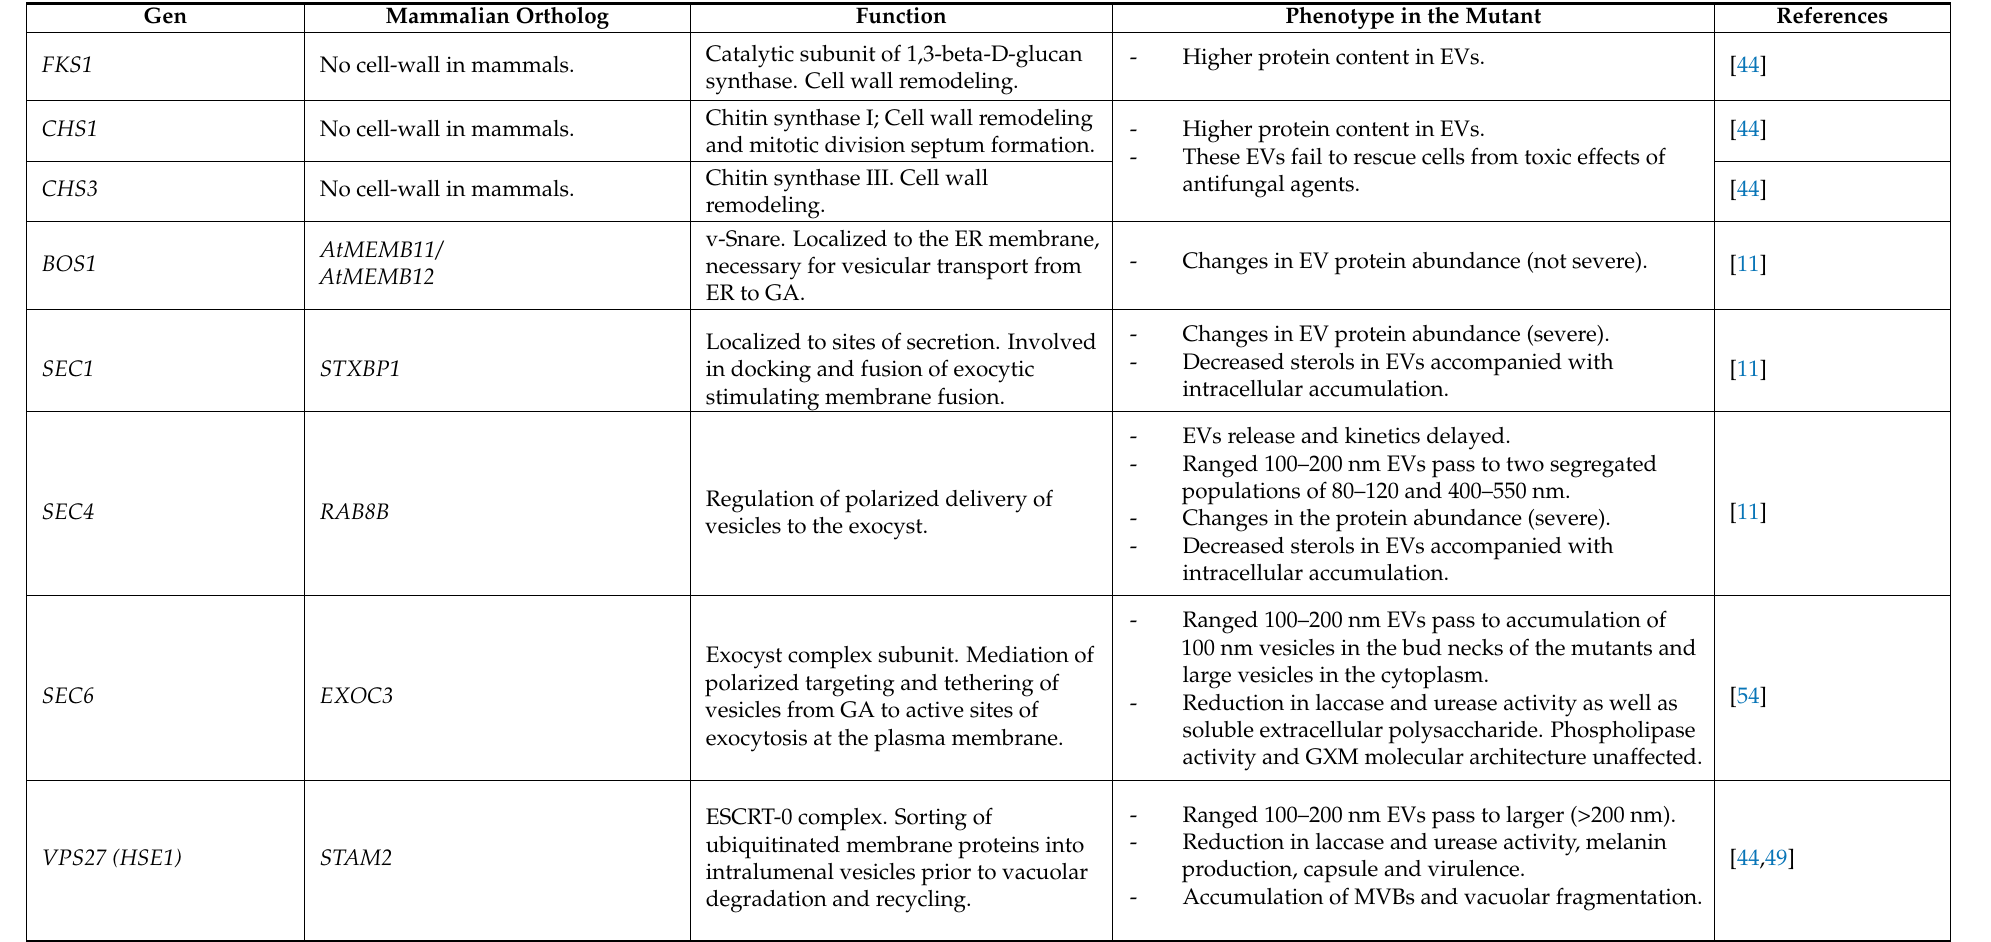
Table 4. Genes involved in biogenesis of fungal